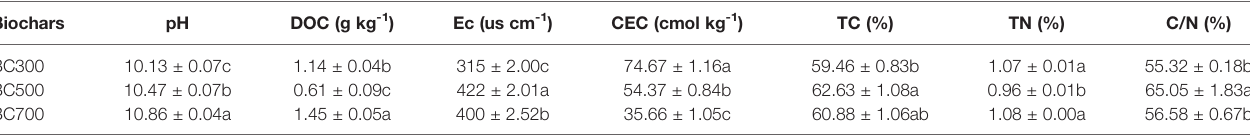
TABLE 1 | Basic characteristics of biochar produced through pyrolysis of wheat straw at 300°C (BC300), 500°C (BC500), and 700°C (BC700). Biochars